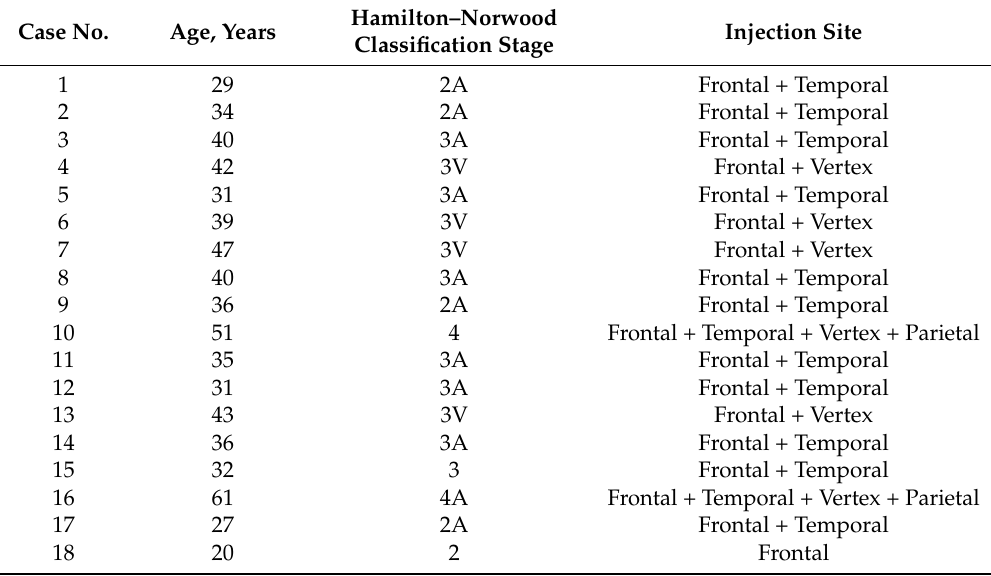
Table 4. Summary of A-PRP treated patient